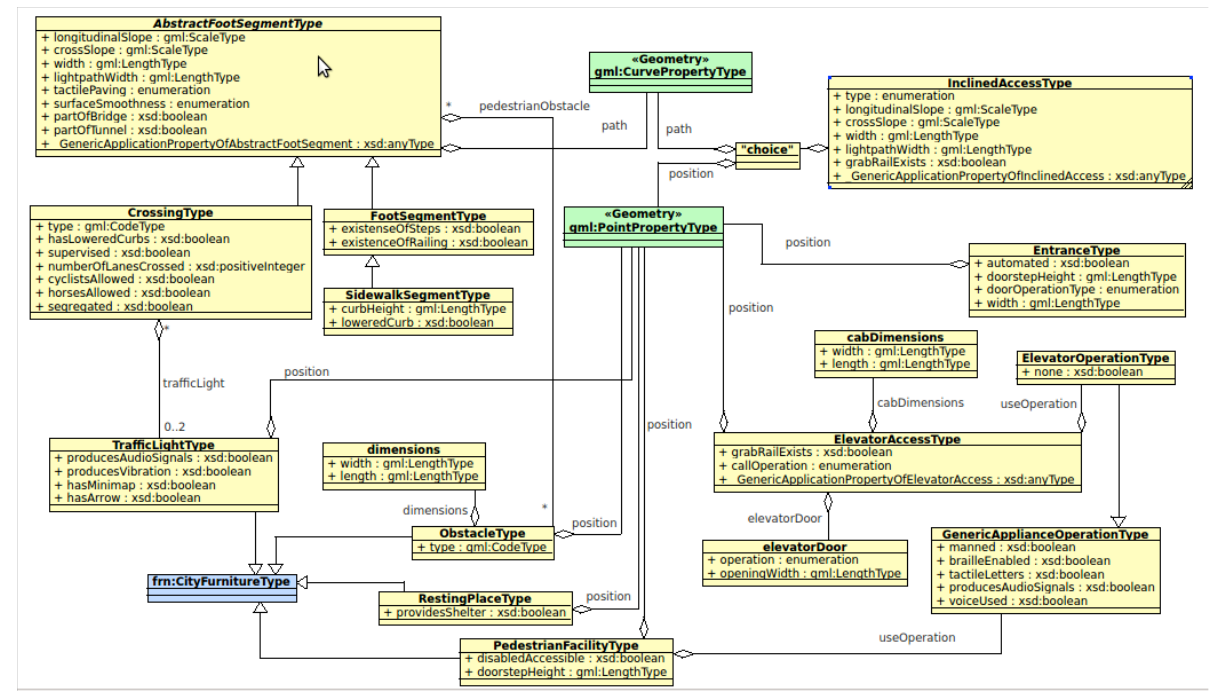
Figure 2: UML diagram of the i-SCOPE inclusive routing